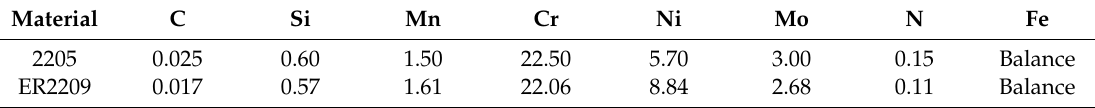
Table 1. Chemical composition of 2205 duplex stainless steel and solid wire (wt.%)